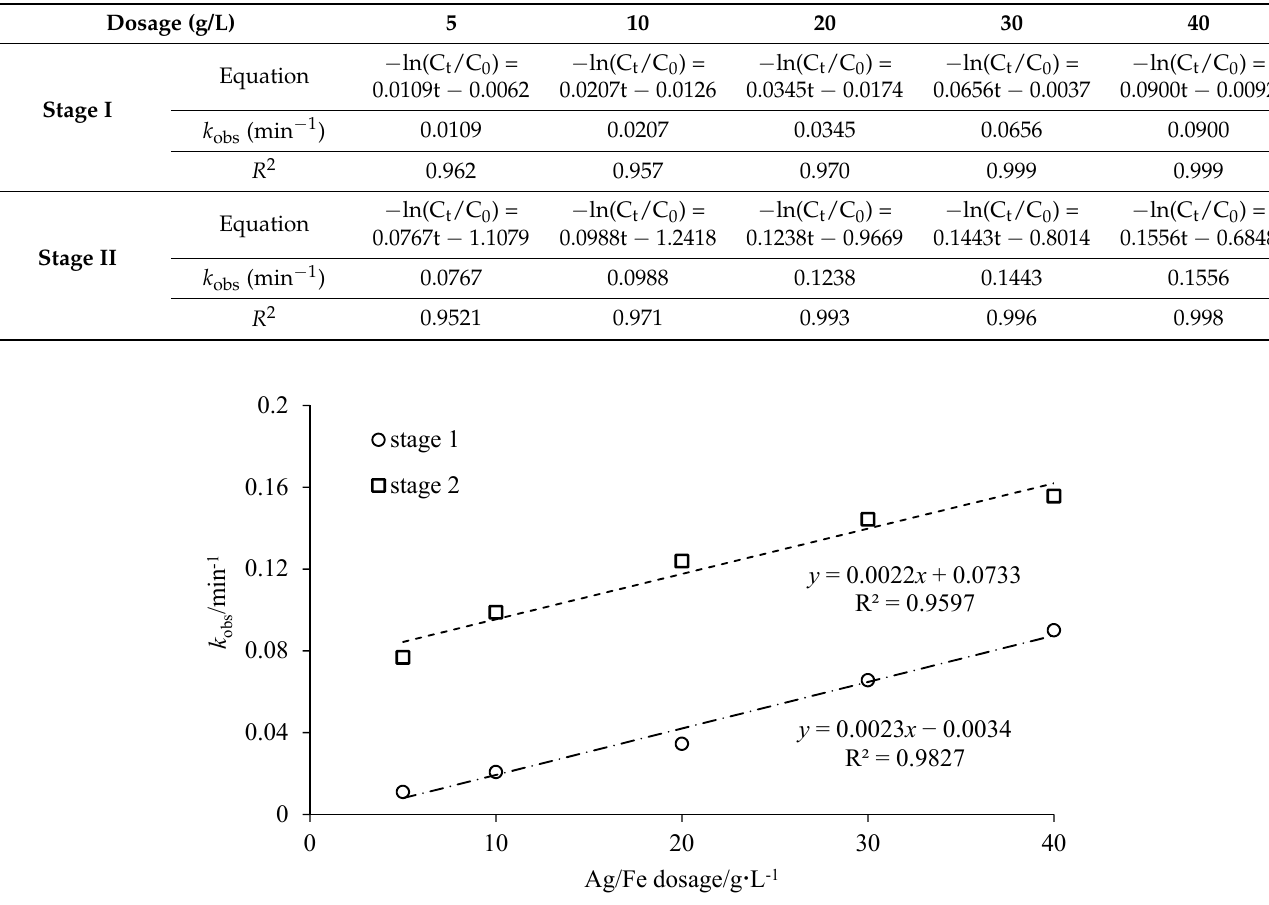
Figure 7. Correlations between the rate constants ( k obs ) of CCl 4 degradation and the Ag/Fe dosage.